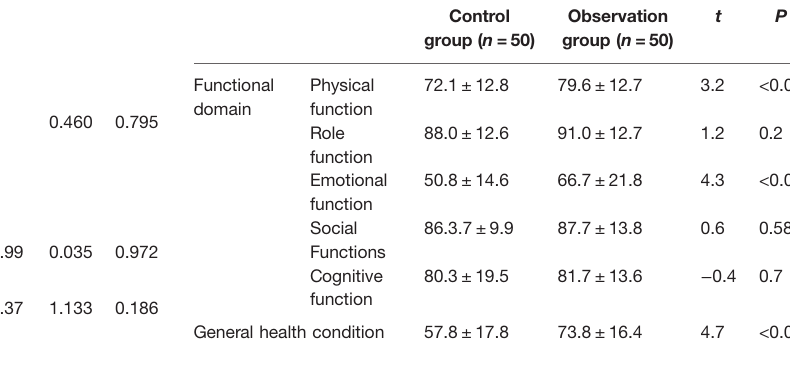
TABLE 5 | Quality of life QLQ-C30 of two groups at return visit in the hospital one month after